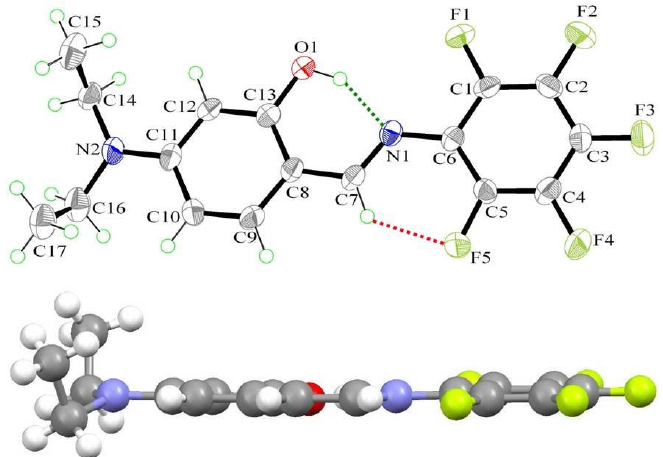
Figure 3. The molecular structure of 4 , showing the atom-labelling scheme. Displacement ellipsoids are drawn at the 50% probability level. Green and red dashed lines denote the intramolecular O–H  N and C–H  F hydrogen bonds,